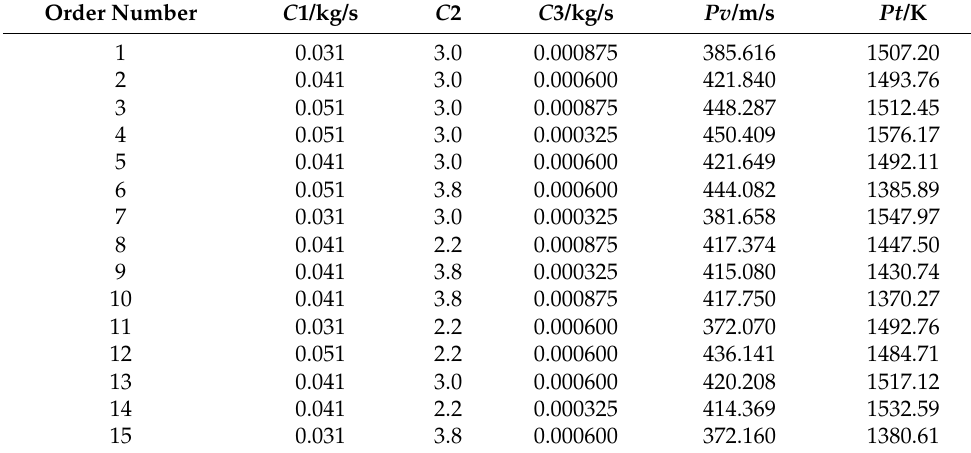
Table 2. Random plan and calculation